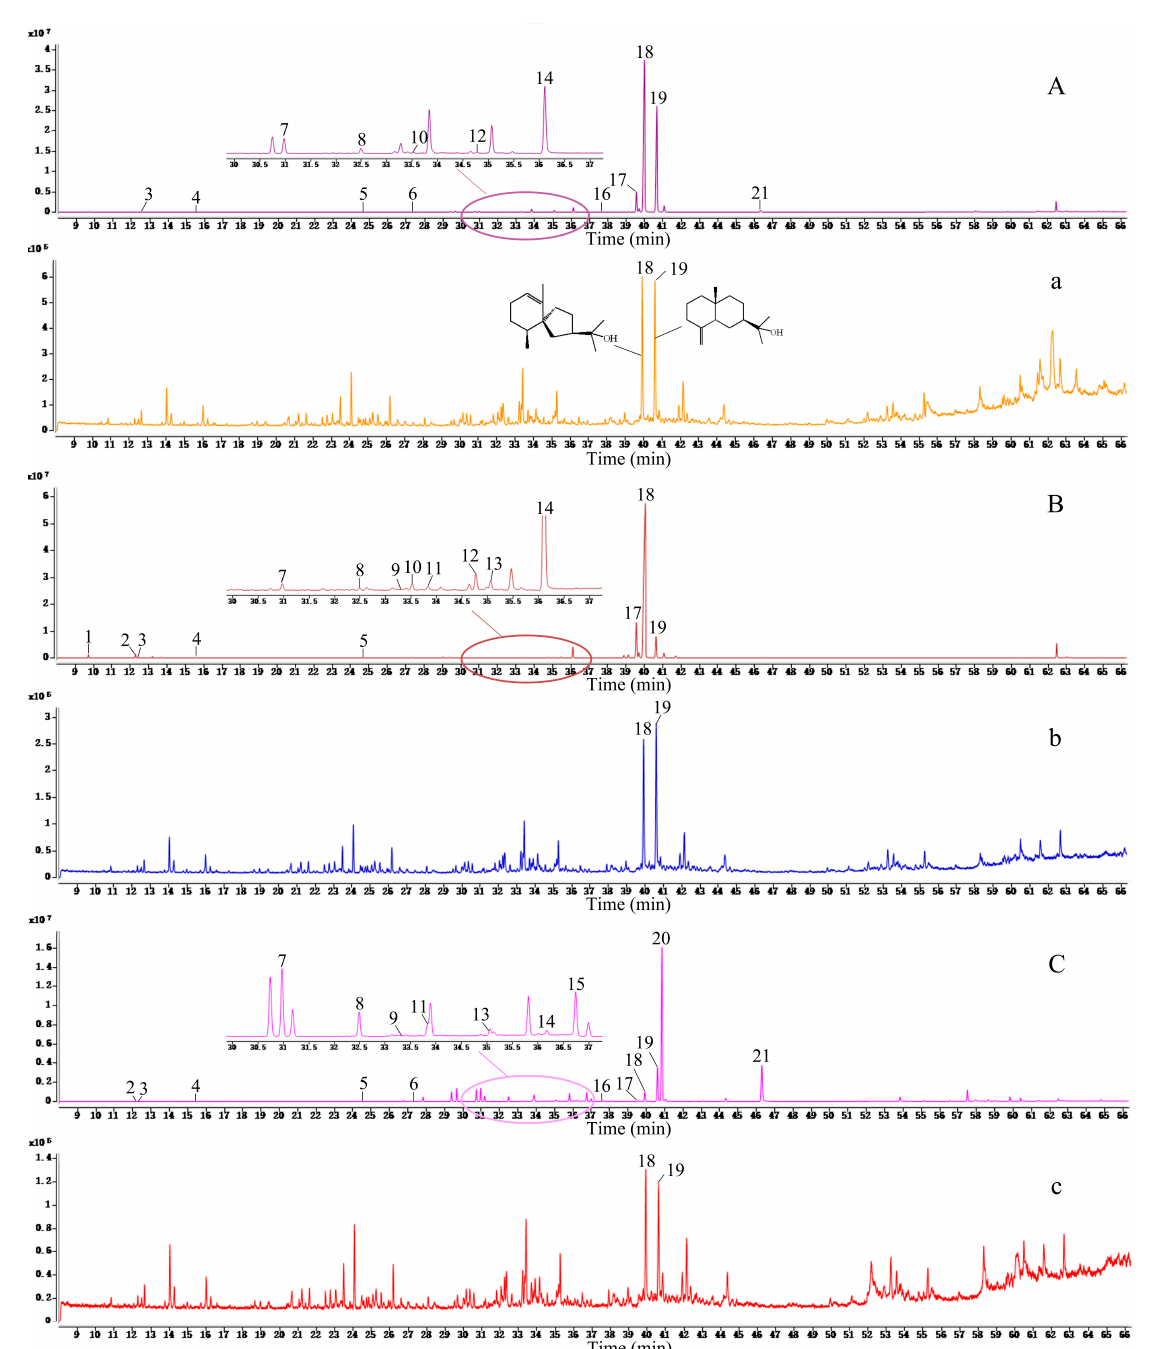
Figure 7. TIC chromatograms for Atractylodes lancea from three regions: ( A ) A. lancea from Tongbai Mountain, Henan Province; (a) frosts of A. lancea from Tongbai Mountain, Henan Province; ( B ) A. lancea from Yuexi, Anhui Province; (b) frosts of A. lancea from Yuexi, Anhui Province; ( C ) A. lancea from Nanjing, Jiangsu Province; (c) frosts of A. lancea from Nanjing, Jiangsu Province. The authors would like to apologize for any inconvenience caused to the readers by these changes.